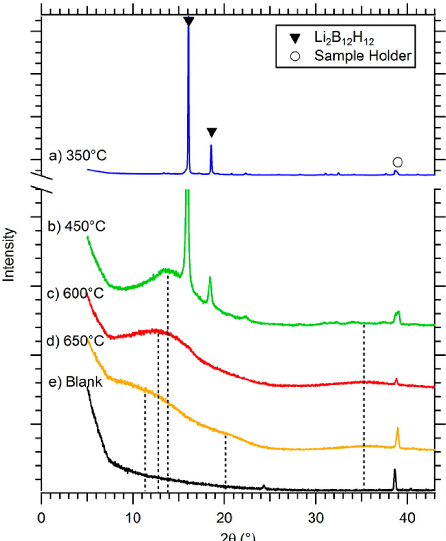
Figure 7. XRD data from thermally decomposed anhydrous crystalline Li 2 B 12 H 12 before and after the main H 2 evolution peak at ca. 440 ◦ C. Reprinted from